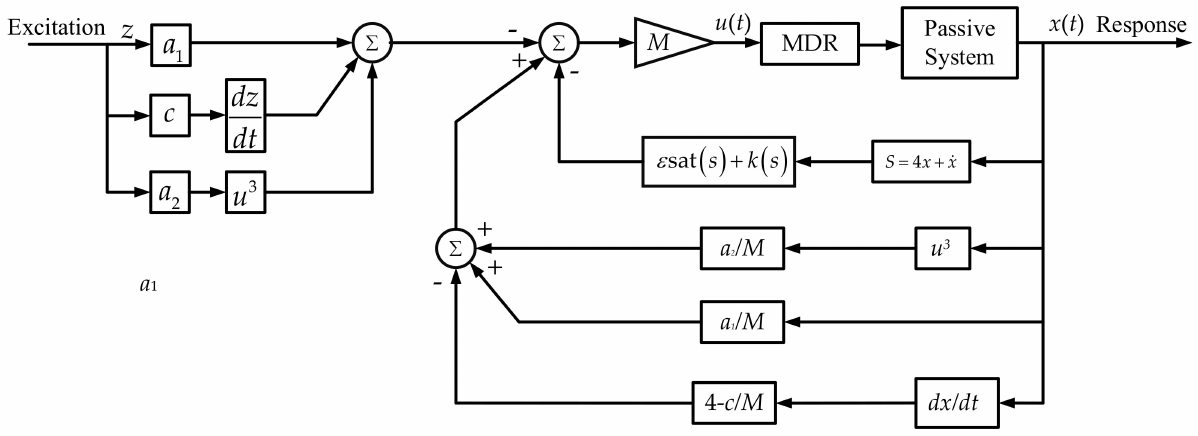
Figure 4. The control architecture of the